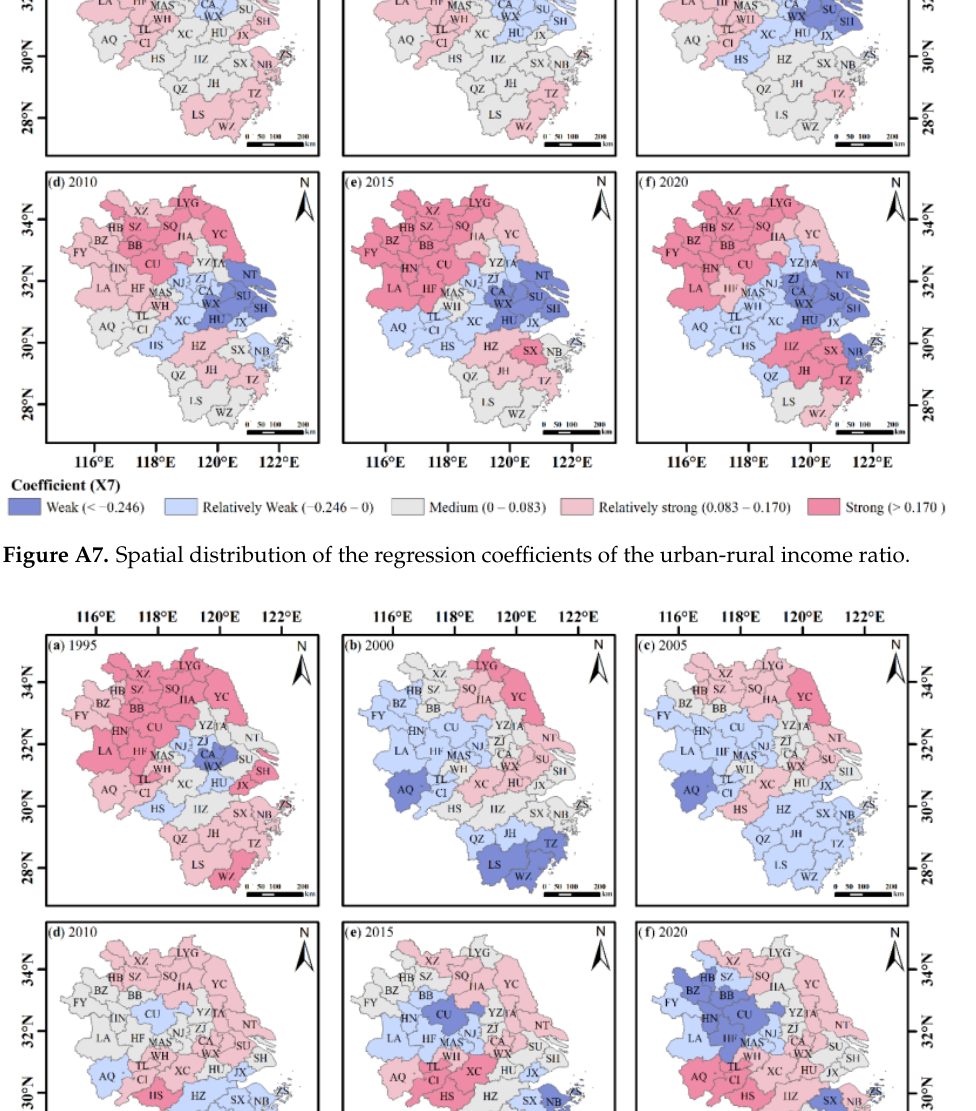
Figure A9. Spatial distribution of the regression coefficients of the carbon emission intensity.